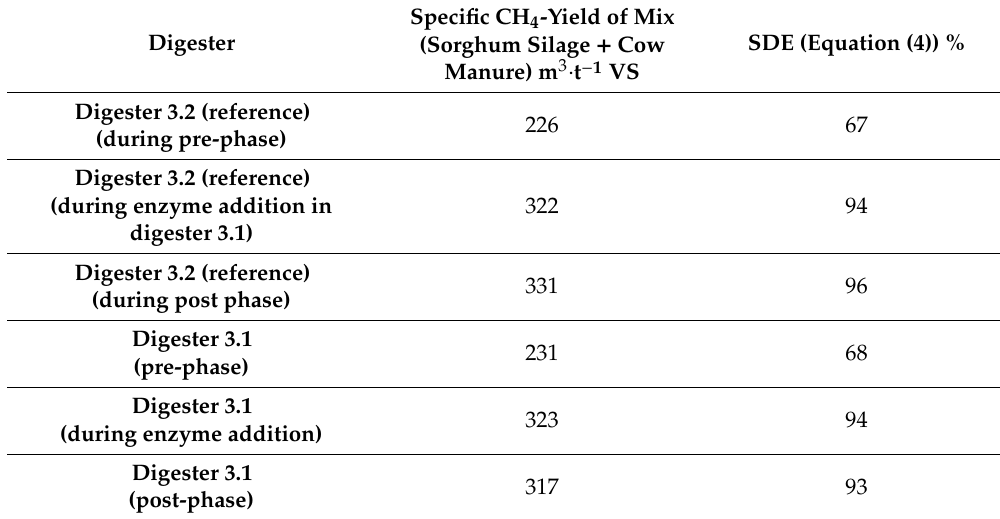
Table 3. Specific methane yields and substrate degradation efficiency.